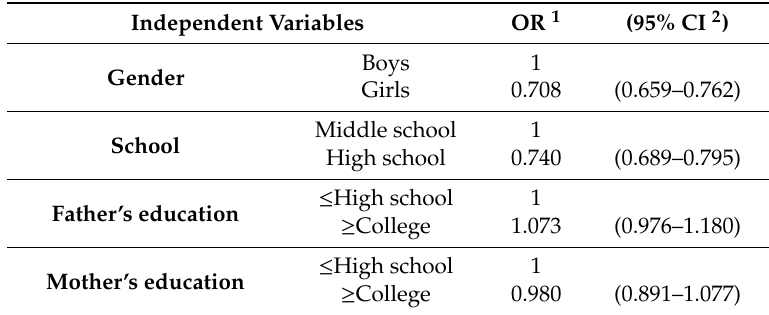
Table 4. Results of Logistic Regression Analysis for the E ff ects of Eating Experience at Convenience Stores on Good Self-Rated